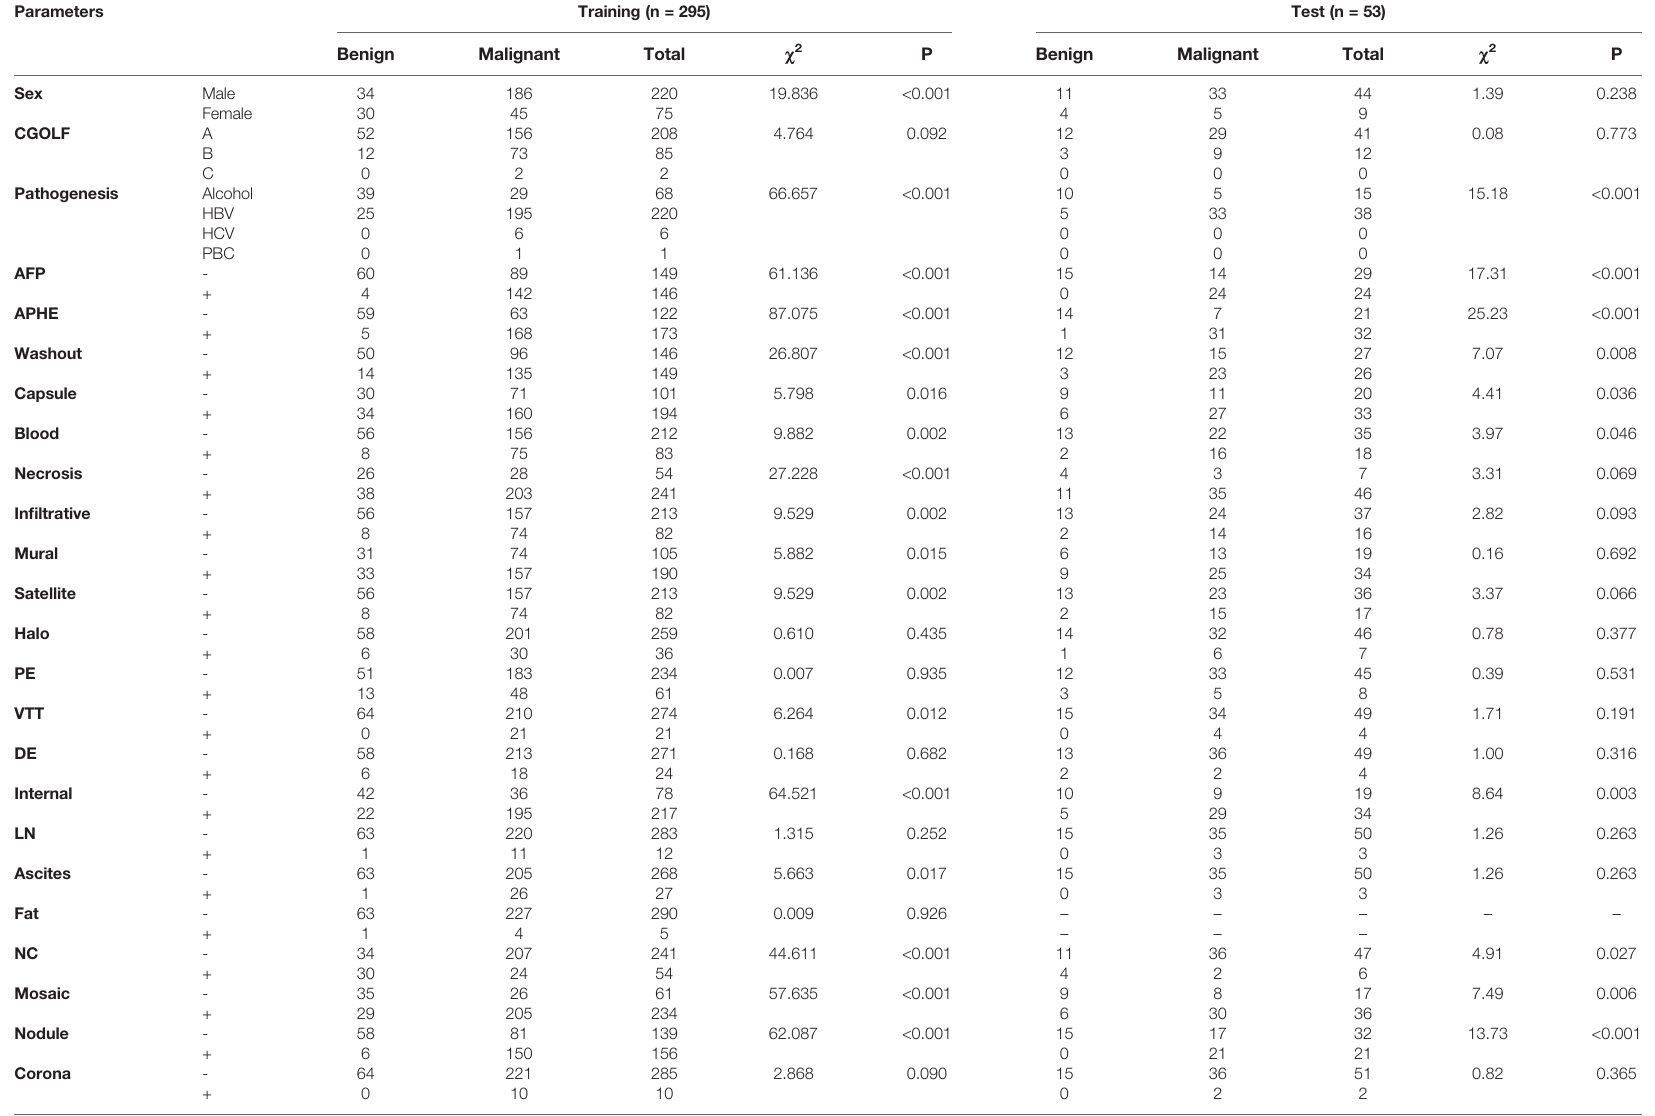
CGOLF, Child grading of liver function; HBV, Hepatitis C virus; HCV, Hepatitis C virus; PBC, Primary biliary cirrhosis; APHE, non-rim Arterial phase hyperenhancement; Blood, Blood product in mass; In fi ltrative, in fi ltrative appearance; Mural, Mural nodules; Satellite, Satellite lesions; Halo, Halo enhancement; PE, Peritumoral enhancement; VTT, vein tumor thrombus; DE, Delayed enhancement; Internal, Internal artery; LN, Lymph node; NC, Non-enhancing “ capsule ” ; Mosaic, Mosaic architecture; Nodule, Nodule-in-nodule architecture; Corona, Corona